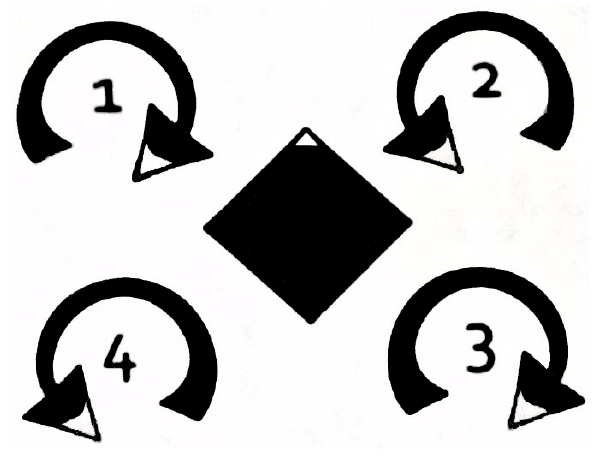
Figure 4. Rotational directions.